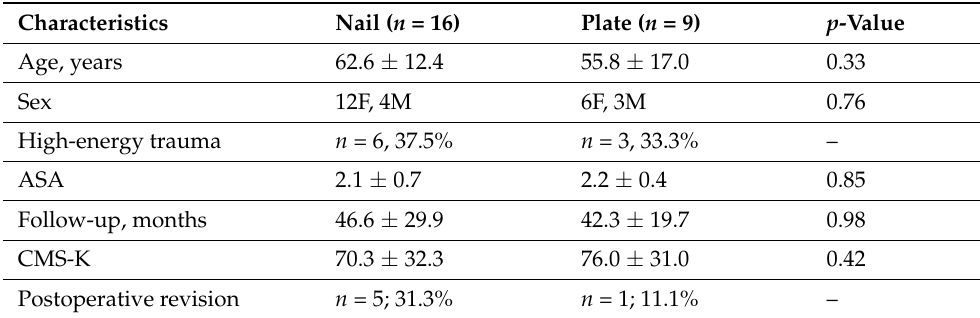
Table 2. Patient characteristics in the NO (Nail) and PO (Plate) groups together with the correspond- ing p